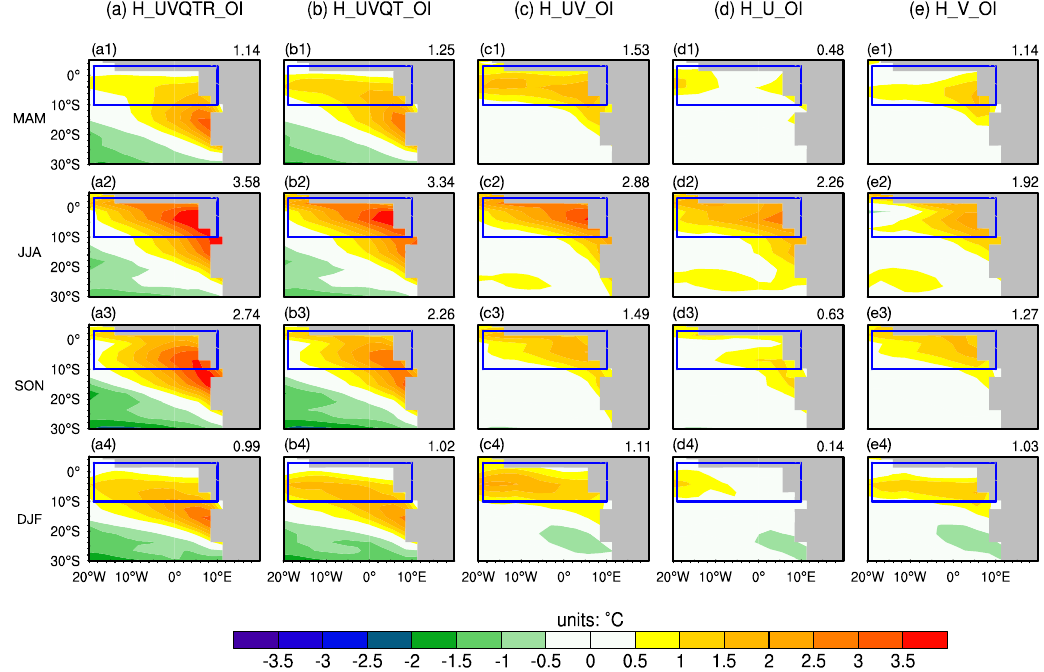
Figure 7. The seasonal mean SST bias (unit: °C) in MAM (top), JJA (second row), SON (third row), and DJF (bottom) during 1979–2005 in H_UVQTR_OI ( a ); H_UVQT_OI ( b ); H_UV_OI ( c ); H_U_OI ( d ); and H_V_OI ( e ). The blue box denotes the ACT region and the area mean of the SST RMSE in the box is given on the top right of the panel.